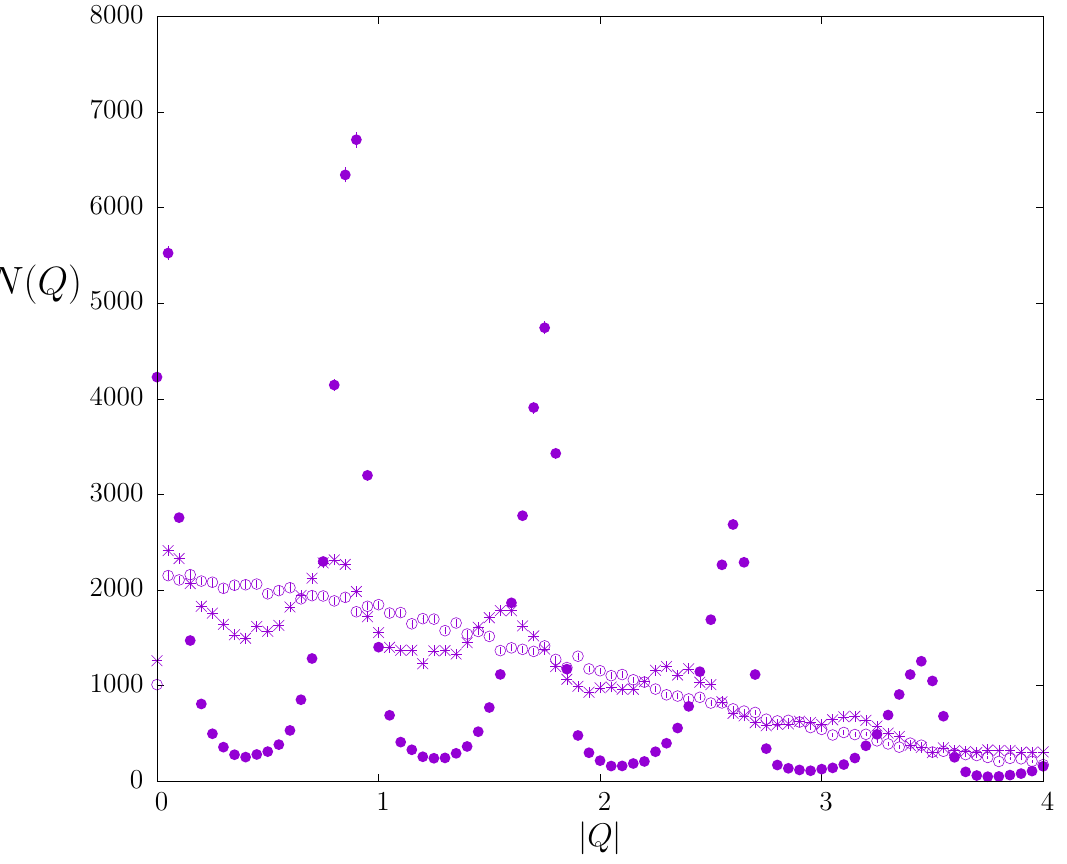
Figure 25 . Histogram of lattice Q after 4 cooling sweeps, ◦ , 8 cooling sweeps, ? , and after 20 cooling sweeps, • on a 8 3 16 lattice at β = 5 . 6924